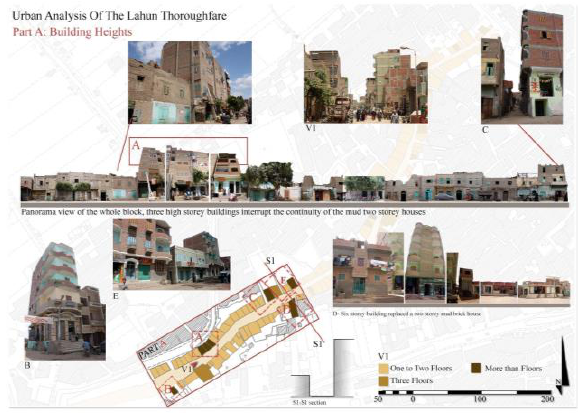
Figure 9. Pictures collage in part of the main street showing building heights, © Author Image Copyright (2010).